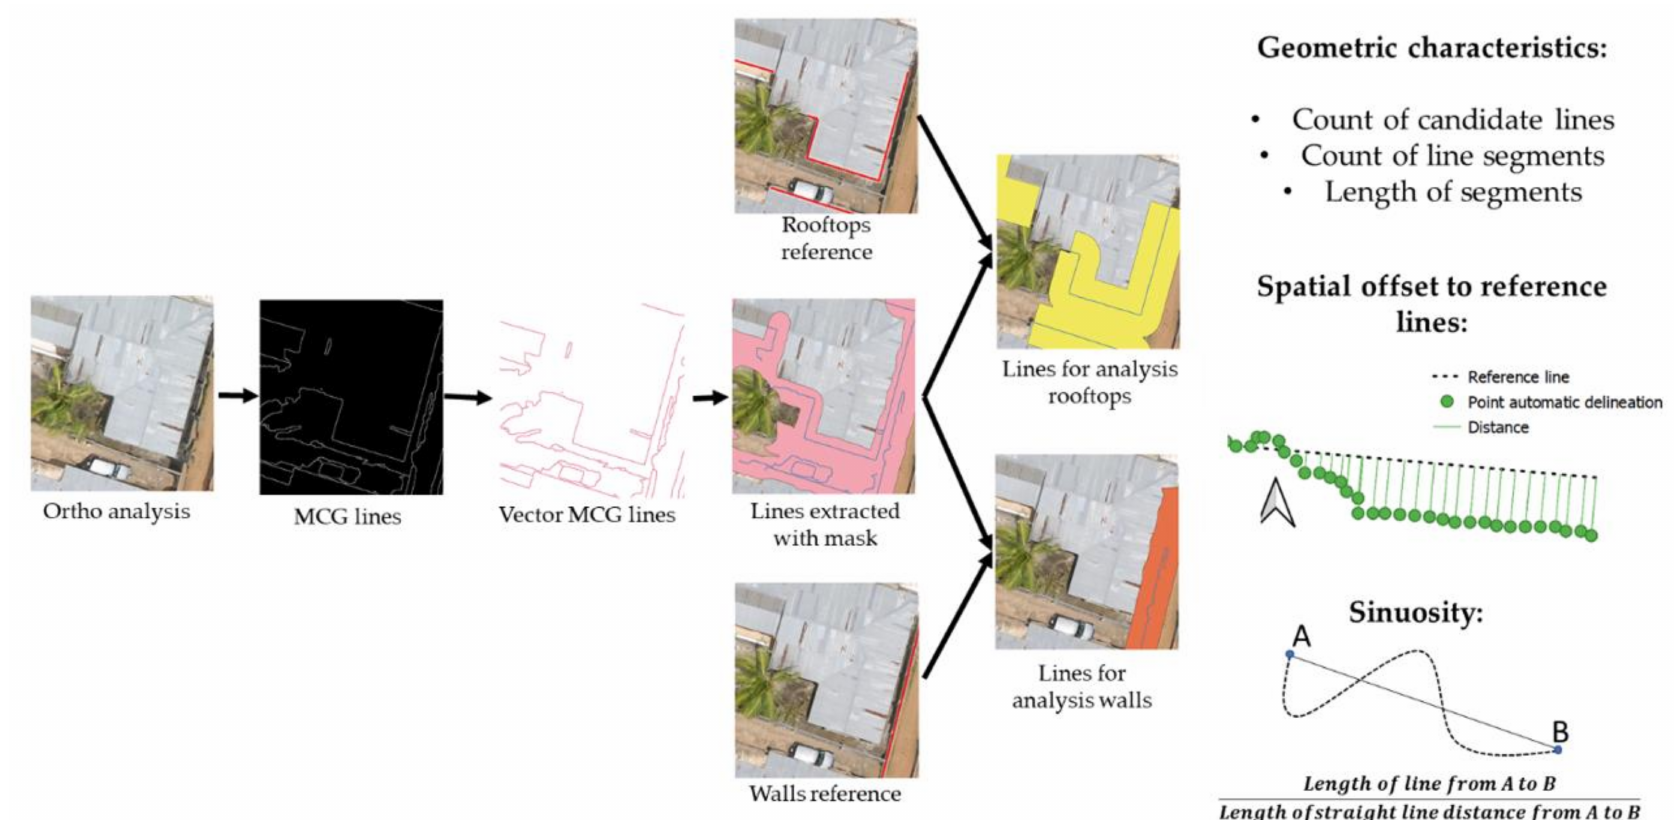
Figure 5. Workflow to compute and select MCG lines representing rooftops or walls and analytical tools to describe geometric characteristics of selected MCG